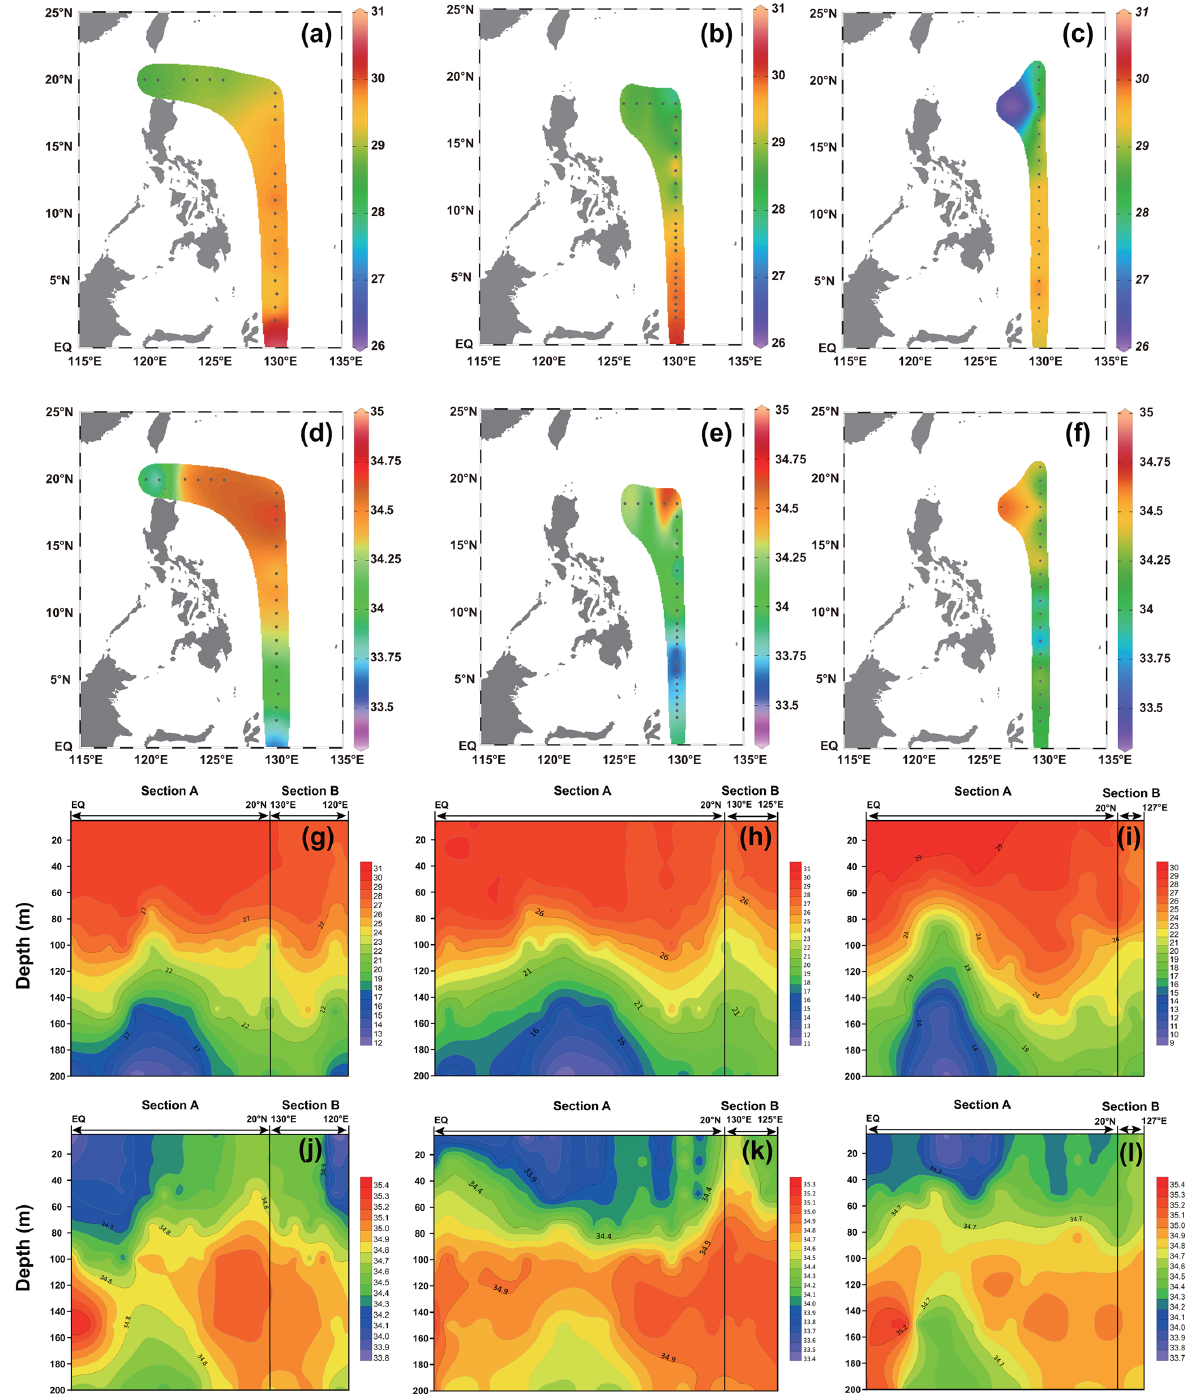
Figure 2. The temperature and salinity distribution in the WPO from three cruises. (a–c) Surface temperature in 2016, 2017, and 2018, respectively; (d–f) surface salinity in 2016, 2017, and 2018, respectively; (g–i) vertical distribution of temperature in 2016, 2017, and 2018, respectively; and (j–l) vertical distribution of salinity in 2016, 2017, and 2018,